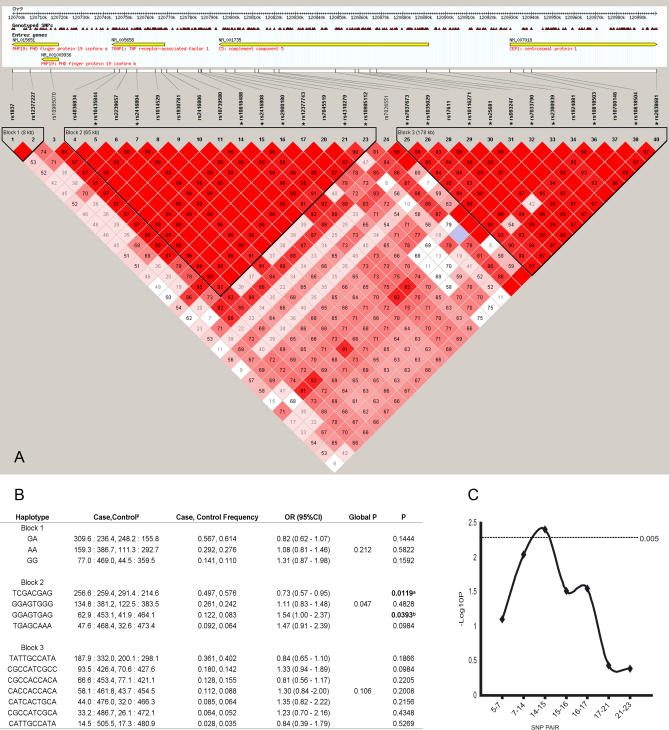
LD Structure and Haplotype Association across the TRAF1/C5 Region in Sample Set 1 (290 RA Patients and 254 Controls)(A) Haplotype block structure was predicted on the basis of the strength of pairwise LD, which is presented as a 2×2 matrix; red represents very high LD (D'), white indicates absence of correlation between SNPs, and blue indicates high correlation with a low level of significance. SNPs that were chosen for haplotype analysis are indicated along the top by an asterisk.(B) Using htSNPs from each block, indicated by the asterisk in (A), haplotypes were inferred with a certainty of above 98% as represented by the R
2
h value. ¥Comparisons were made between one haplotype versus all others in cases and controls. aThe protective haplotype that is significantly less frequent in cases. bThe susceptible haplotype that is significantly more frequent in patients.(C) Sliding window of the susceptible haplotype using consecutive two-SNP combinations of the htSNPs reveals that SNP14 and SNP15 account for most of the association observed. For each of the SNP pairs we show the –log10
p-value. The dotted line indicates a nominal p-value of 0.005.